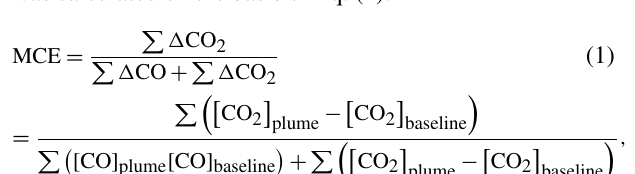
was calculated on the basis of Eq.